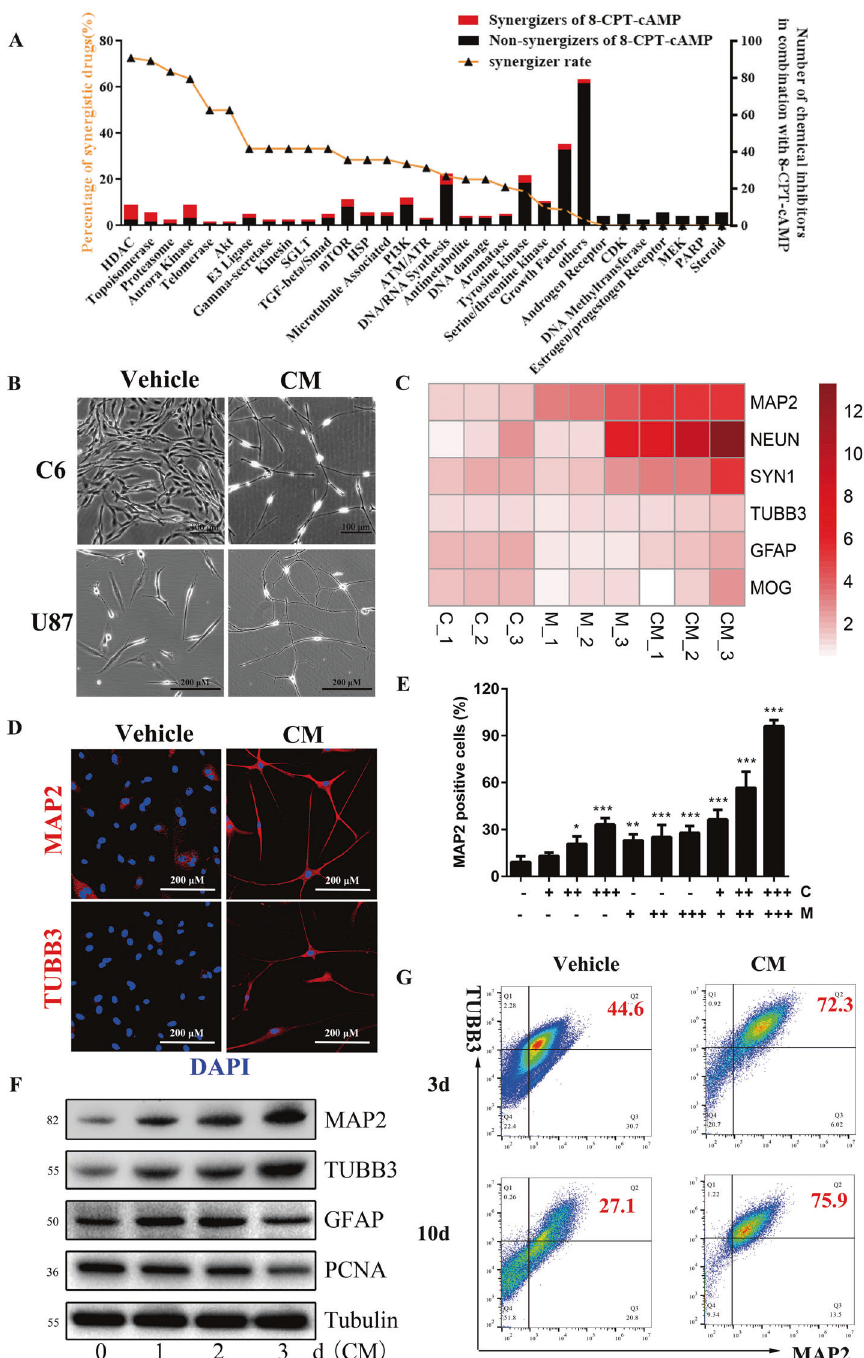
Fig. 1 HDAC inhibitors cooperate with 8-CPT-cAMP to induce neuronal differentiation of human glioblastoma cells. A The percentage of drugs showing synergistic activity with 8-CPT-cAMP in agents grouped by targets. B Morphology alteration of rat malignant glioma C6 cells and human glioblastoma U87MG cells treated with CM for 2 days. V: Vehicle (1 ‰ DMSO); C: 0.5 mM 8-CPT-cAMP; M: 1 μ M MS275. C The fold change of neuronal genes in the C, M, CM-treated group compared with the control group. D Immuno fl uorescence analysis of MAP2 (upper, red) and TUBB3 (down, red) in U87MG cells treated with CM for 2 days. The nucleus was stained with DAPI (green). E The percentage of MAP2- positive cells exposure to different regimens of CM. C: + 0.125 mM, ++ 0.25 mM, +++ 0.5 mM; M: + 0.25 μ M, ++ 0.5 μ M, +++ 1 μ M. Data are shown as mean ± SD ( n = 3 per group). Compared to vehicle control, one-way ANOVA with Dunnett post-test was used. * P < 0.05; ** P < 0.01; *** P < 0.001. F Western blot analysis of MAP2/TUBB3/GFAP/PCNA in CM-treated U87MG cells for 2 days. Tubulin was used as a loading control. G Flow cytometry analysis of the MAP2/TUBB3 in U87MG cells treated with CM for 2 days for 3 and 10 days. The red numeric in the upper right corner represents the percentages (%) of MAP2-positive and TUBB3-positive cells in all tested cells.